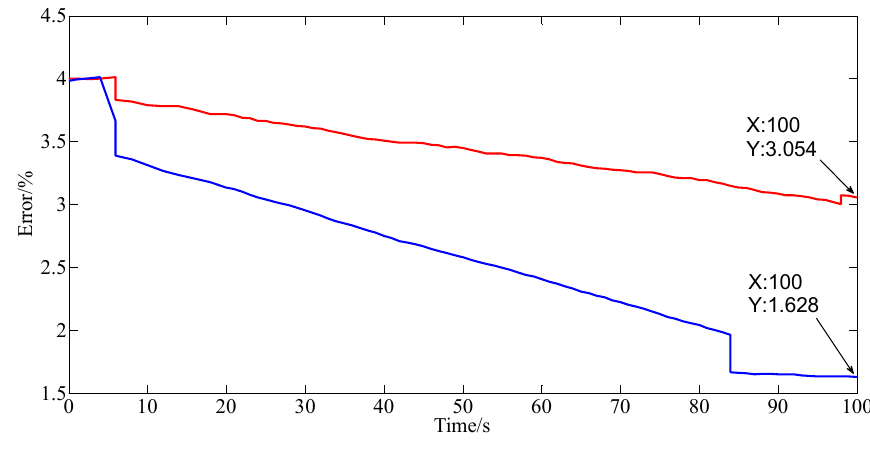
Figure 14. Error comparison in a time period of 100 s .